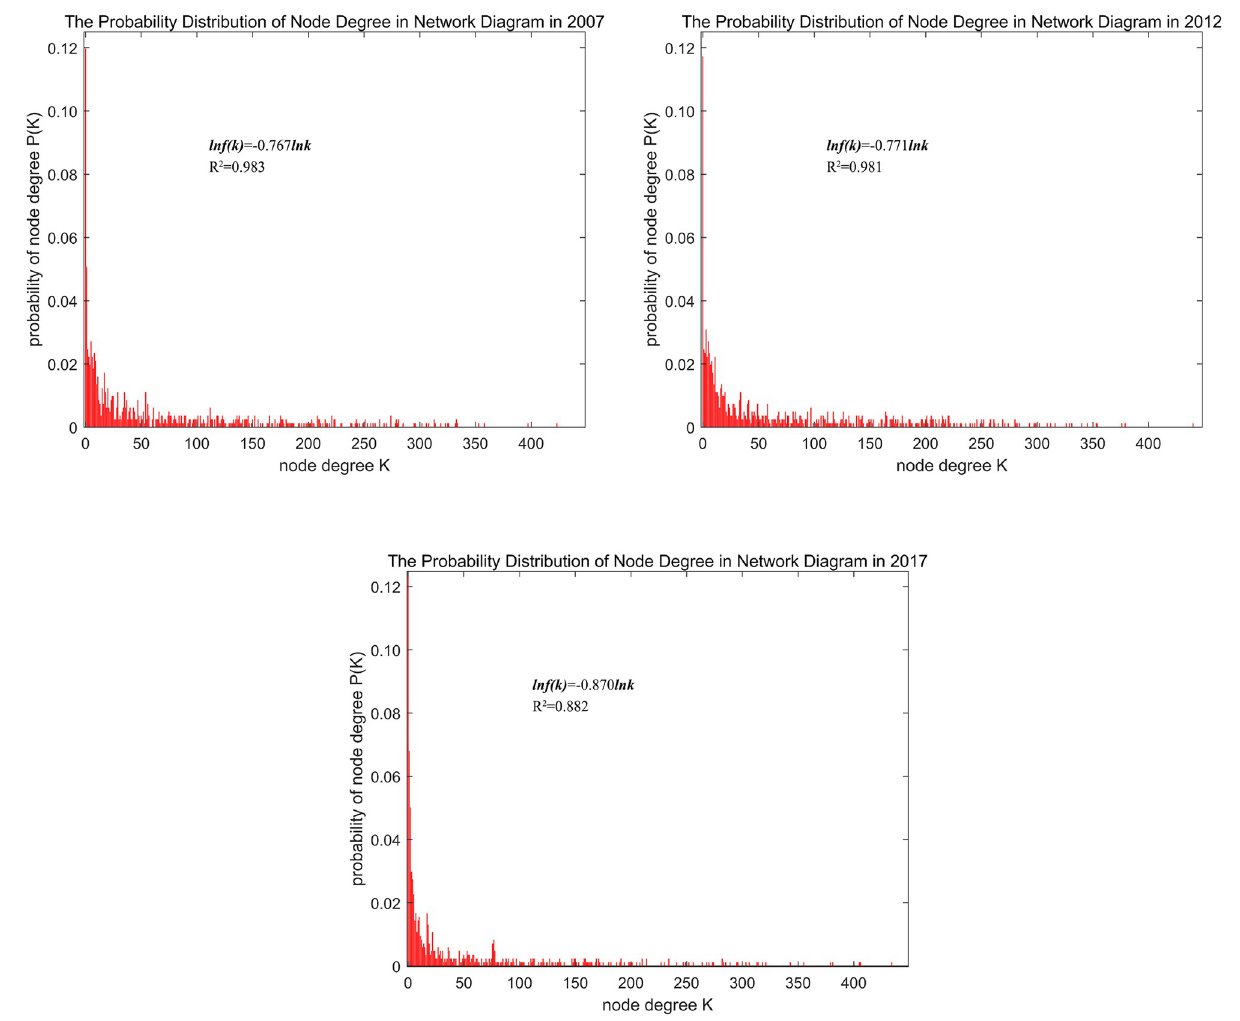
Fig 1. Node degree probability distributions in the network diagrams for 2007, 2012 and